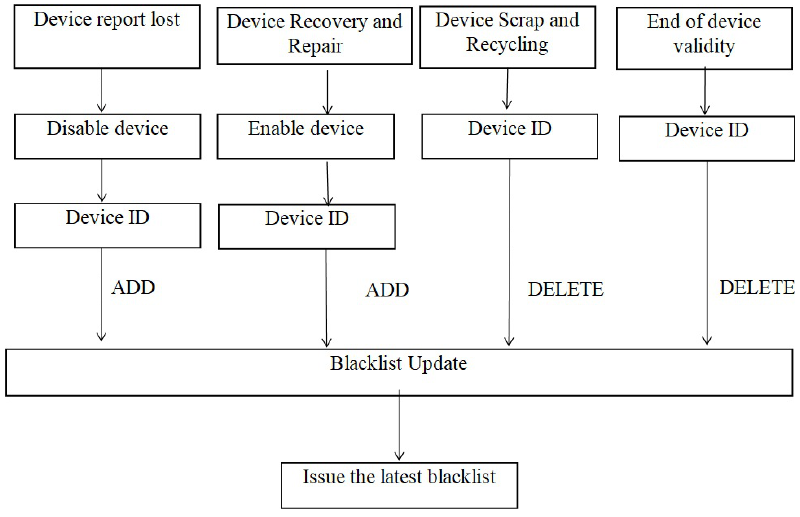
Fig. 6 Device blacklist management